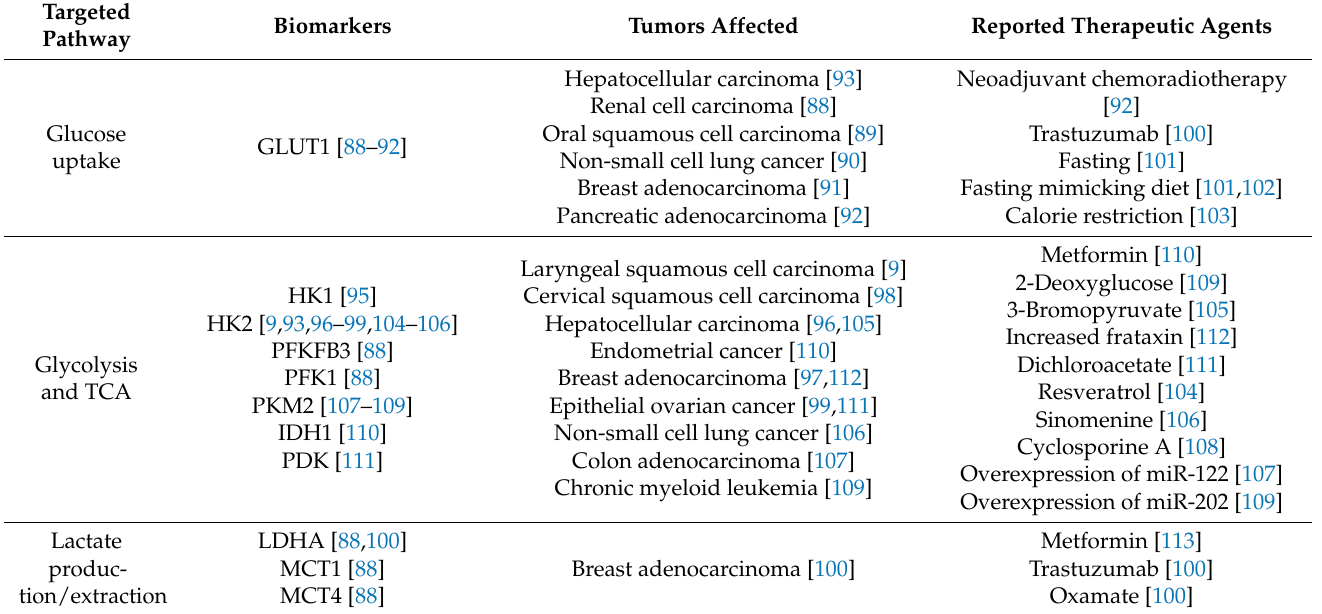
Table 3. Carbohydrate metabolic alterations in